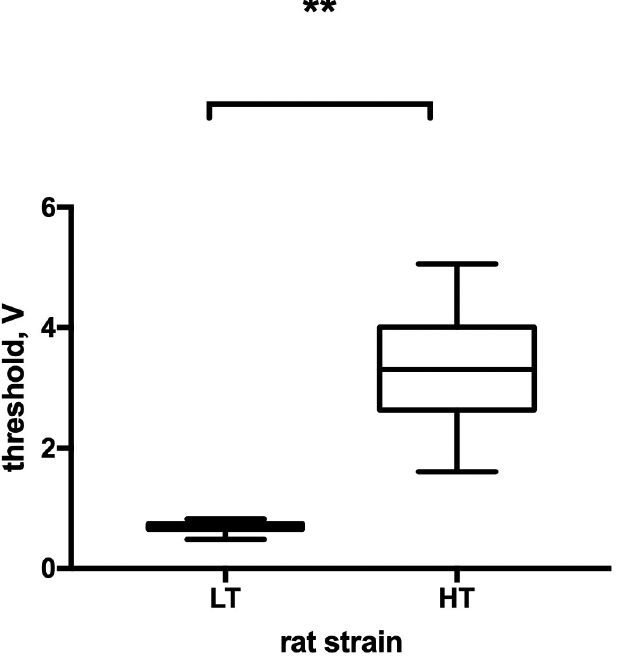
Fig 2. Interstrain differences in the volage threshold in LT and HT rat strains. HT—animals with high excitability threshold, LT–animals with low excitability threshold, n = 32–34 per group; the graphs represent the medians, quartile boundaries, and maximum and minimum values of the analyzed data; �� p � .01 (Mann-Whitney test).